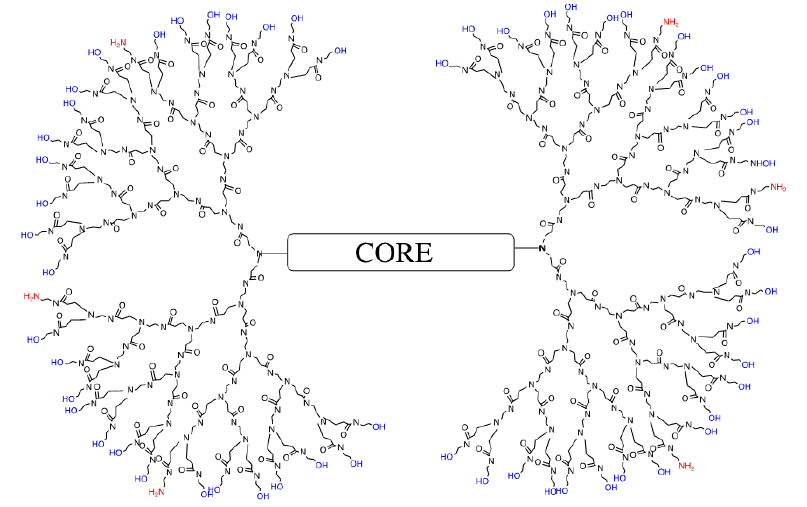
Figure 1. Representation of the G4-90/10 with 90% surface hydroxyl groups and 10% surface amine groups.